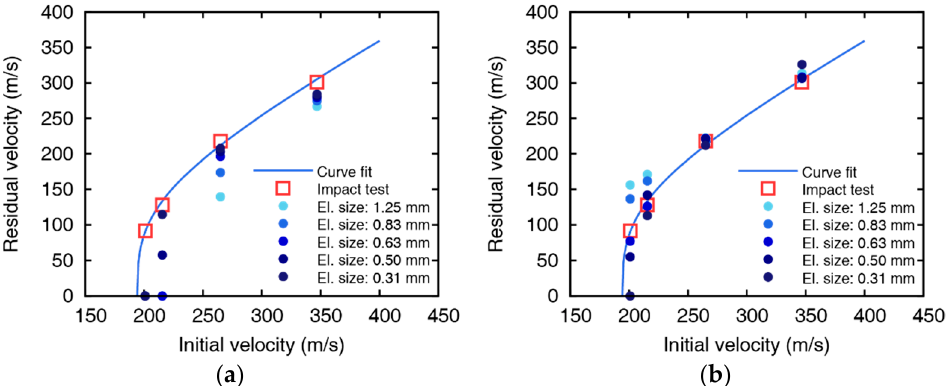
Figure 14. Initial and residual velocities of ( a ) Johnson-Cook damage model and ( b ) EDFS with the curve fit from the impact tests of 10 mm aluminum plates.